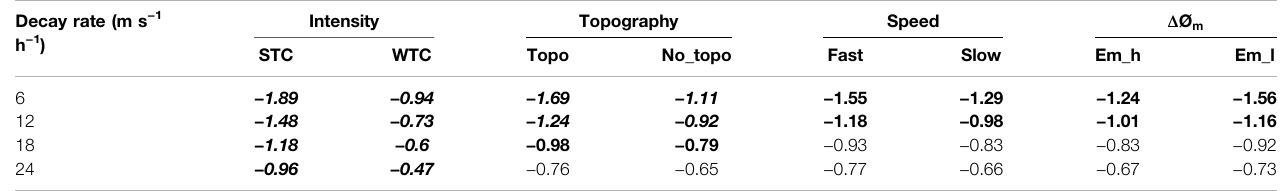
TABLE 2 | Decay rates (m s − 1 h − 1 ) during different periods (0 – 6, 0 – 12, 0 – 18, and 0 – 24 h) after landfall for different classi fi cation groups (STC/WTC, Topo/No_topo, Fast/ Slow, Em_h/Em_l). Boldface and italic fonts indicate the differences being statistically signi fi cant over the 90 and 99% con fi dence level, respectively, based on the Student ’ s t